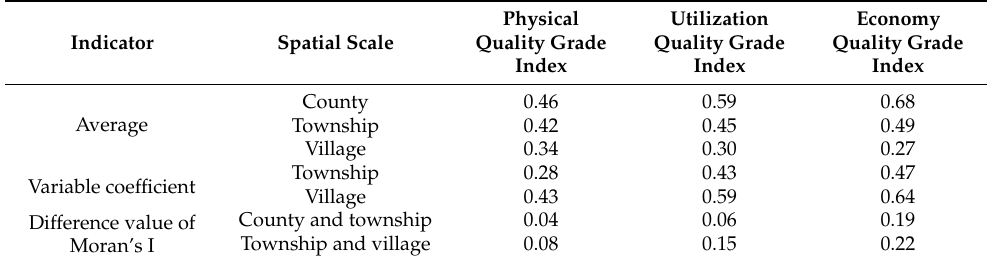
Table 5. Moran’s I value change of global spatial auto-correlation analysis of cultivated land quality under different spatial